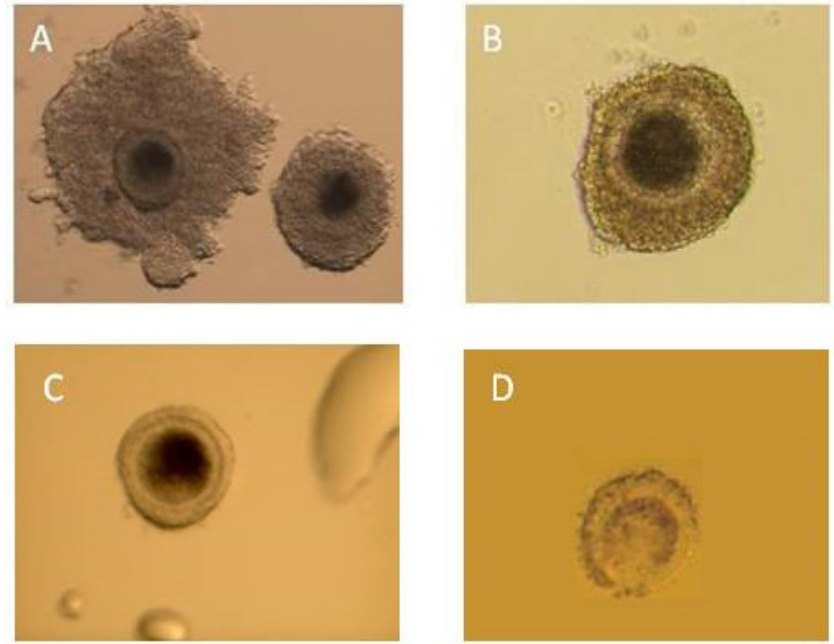
(homogenous) cytoplasm, surrounded by thick compact layers of cumulus cells; ( B ) class Figure 4. Immature oocytes collected using the ovum pick-up technique. ( A ) Class I—excellent quality of cumulus–oocyte complexes (COCs); morphologically normal oocytes with evenly